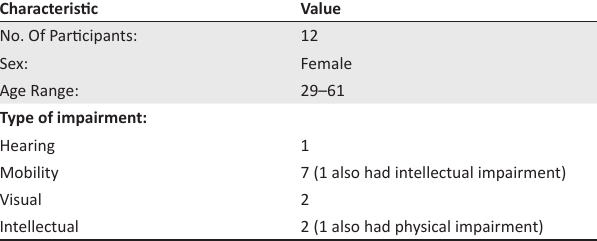
TABLE 1: Participants